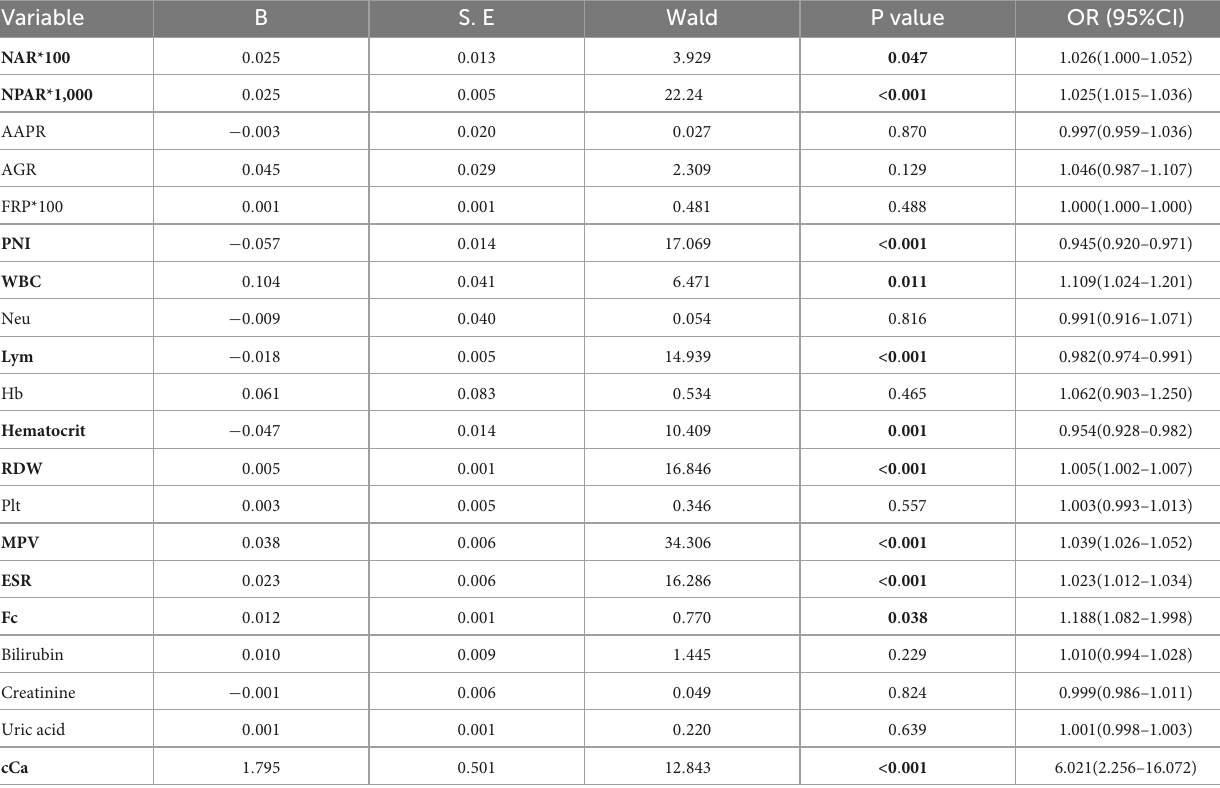
TABLE 3 Results of univariate logistic regression analysis in patients with active and inactive